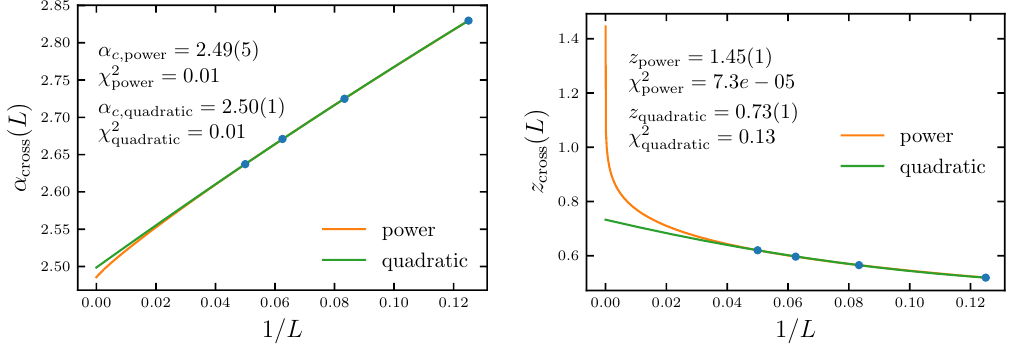
Figure 6: (left) Extrapolation of crossing point of the curves in the right panel of Fig. 5 to the thermodynamic limit using power-law (e.g. α and quadratic fits shown in the plot as orange and green lines respective. (right) Extrapolation of z ( L ) values at the crossing points with a power-law and quadratic fits shown in the plot as orange and green lines respective. The error bars for each point are calculated from the co-variance matrix of the polynomial interpolations and the error bar for the critical point and dynamic exponent in the figure have been calculated the bootstrap method. The χ 2 value for the fit is shown in the figures. We have normalized it by the number of left-over degree’s of freedom, in this case is